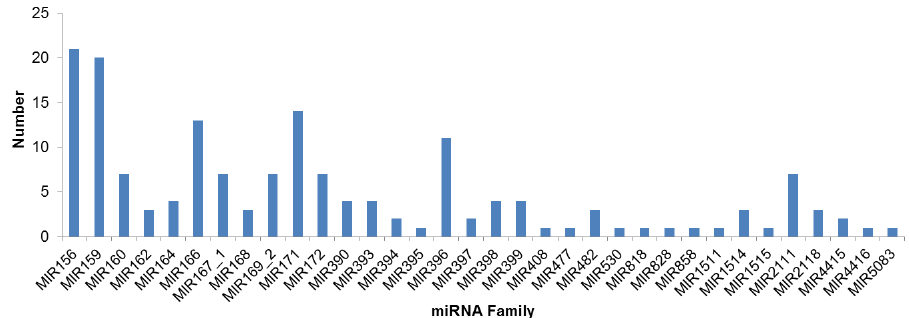
Figure 2. The distribution of the identified distinct miRNA sequences of each conserved miRNA family in A. membranaceus .